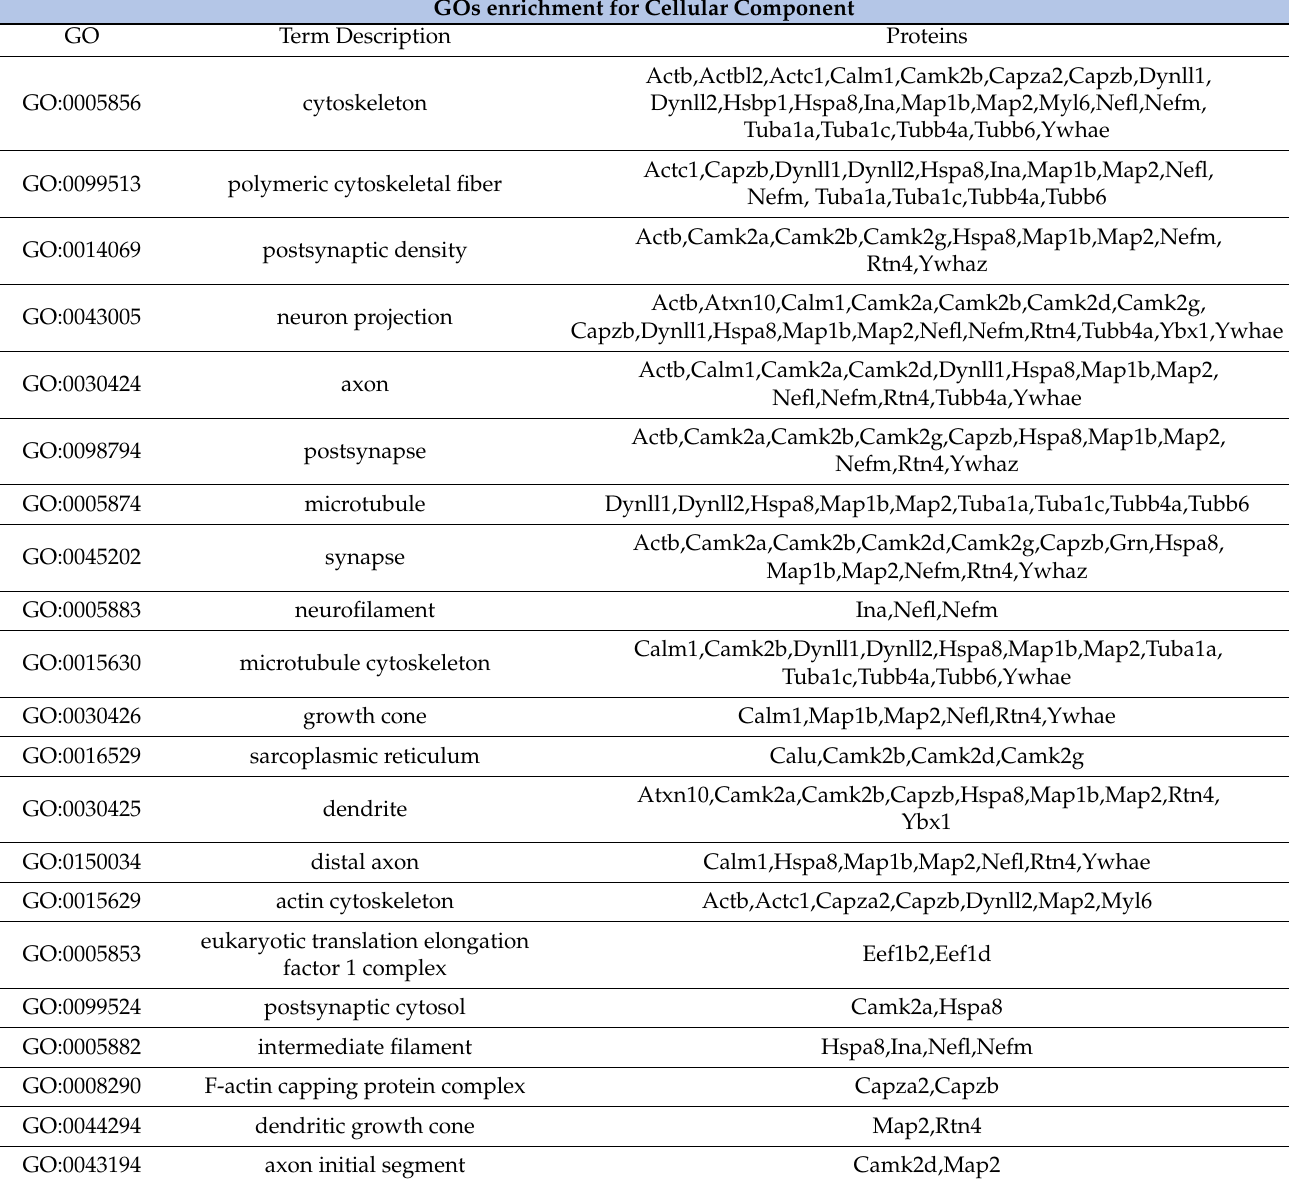
Table 2. Cont. GOs enrichment for Cellular